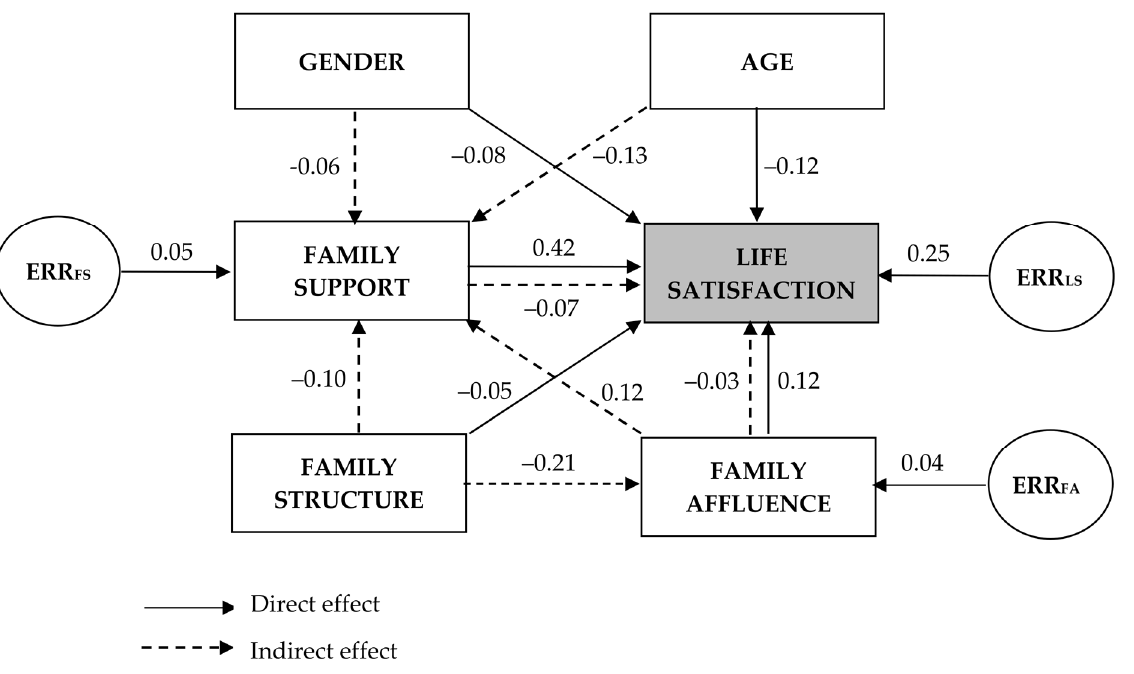
Figure 1. Path model and structural pathways to adolescent life satisfaction: a case of data from Estonia. Notes: the numbers on pathways are standardised coefficients; ERR LS , ERR FA , and ERR FS are errors of corresponding variables which represent unmeasured variables